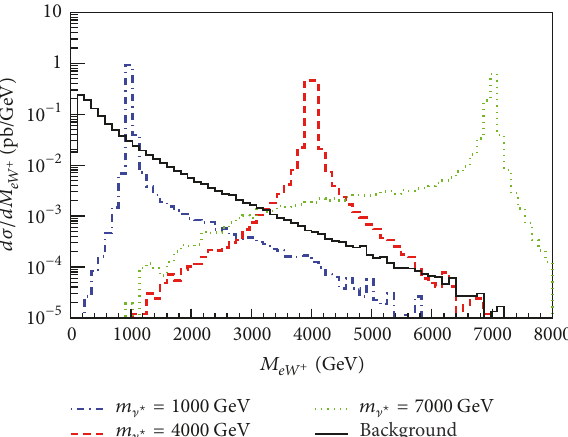
Figure 7: The invariant mass distributions of the excited neutrino signal and the corresponding background for Λ = 𝑚 ] ⋆ and 𝑓 = 𝑓 󸀠 = 1 at the ILC ⊗ FCC